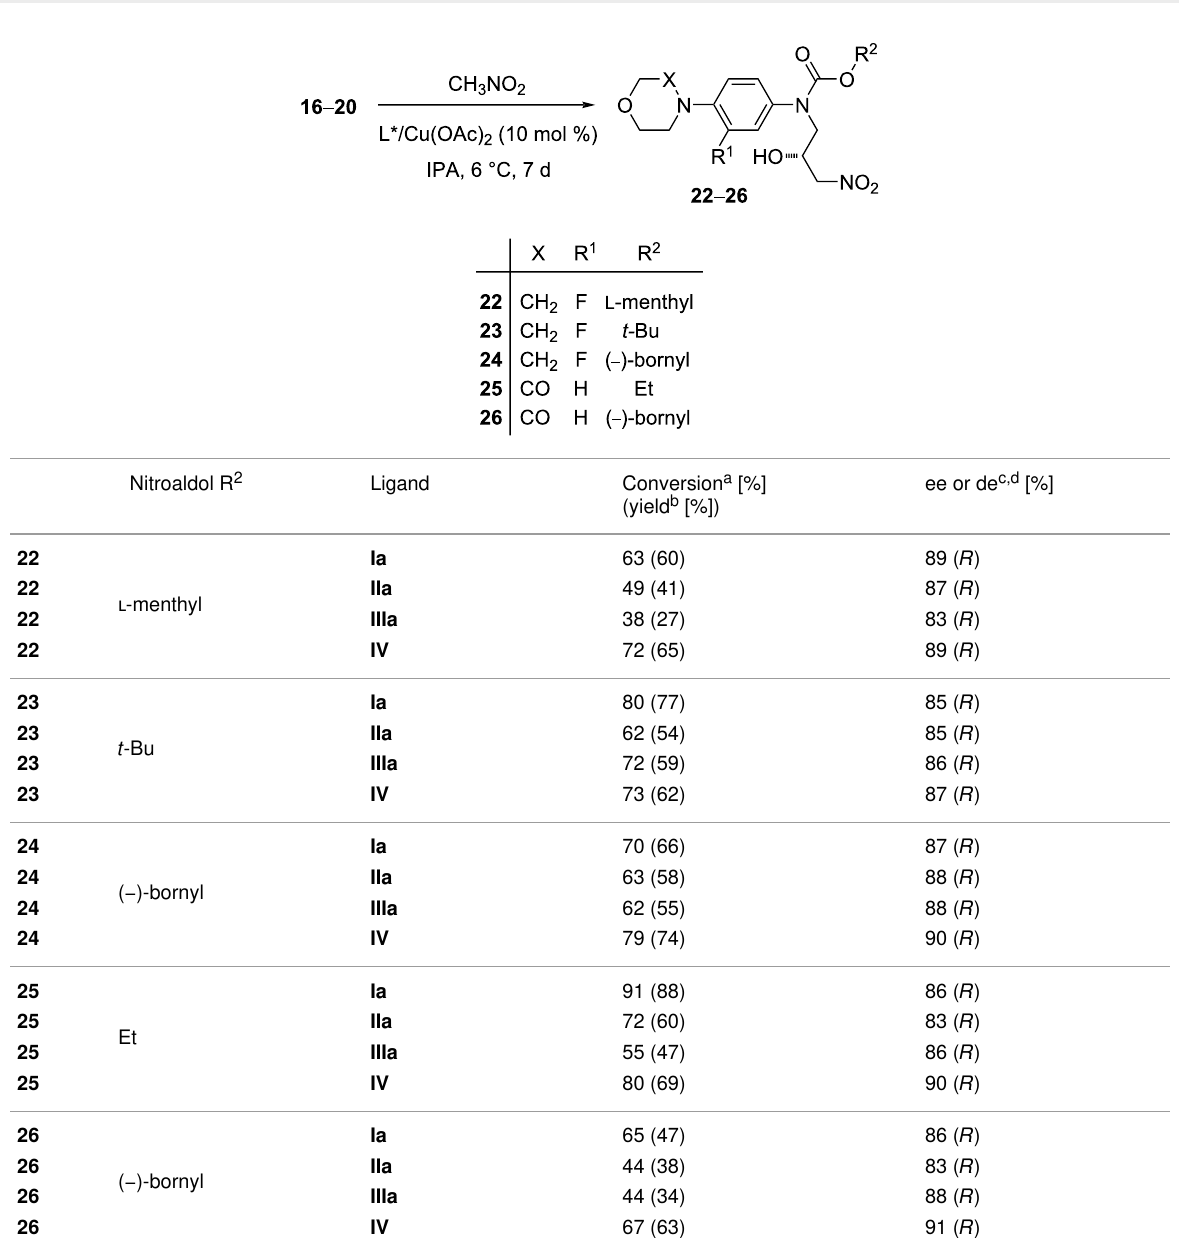
Table 2: Asymmetric Henry reactions of aldehydes 16–20 with nitromethane catalyzed by copper(II) complexes of Ia , IIa , IIIa , and IV